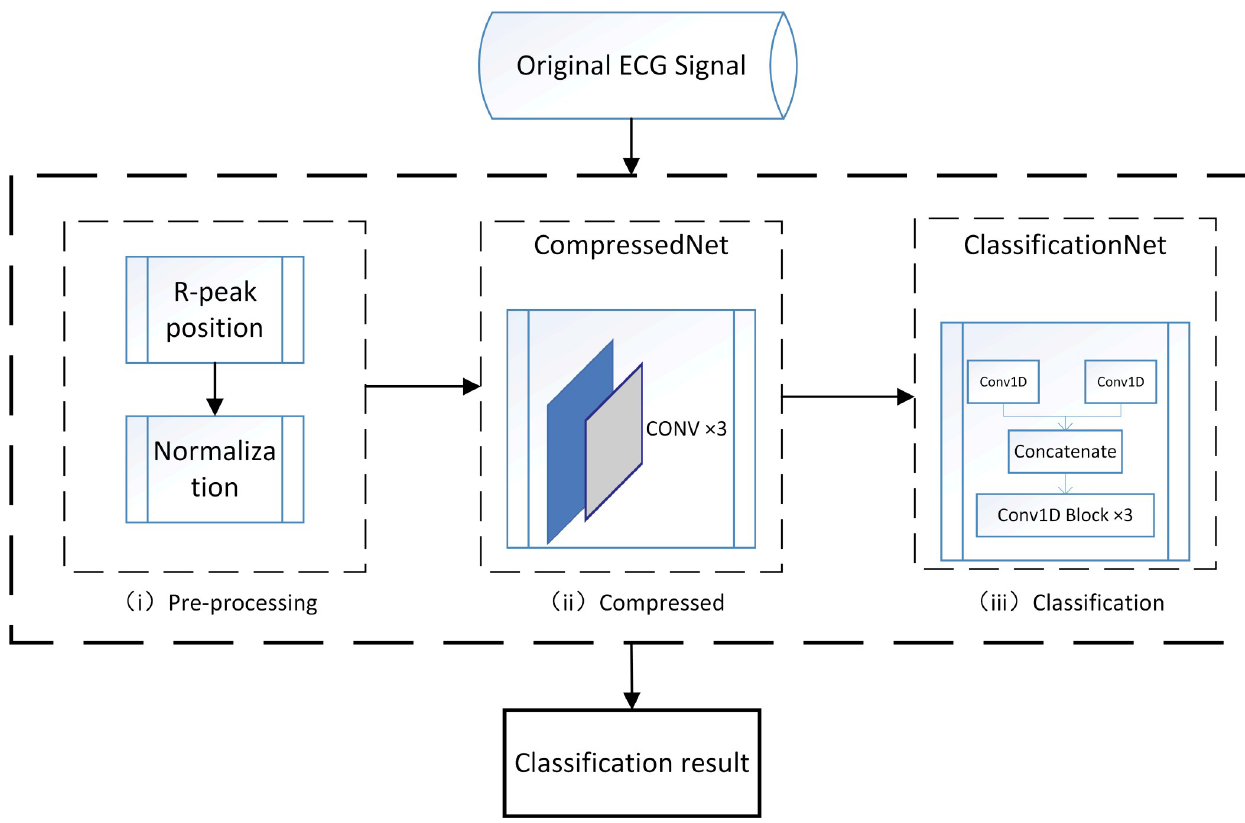
Fig 1. ECG signal compression classification